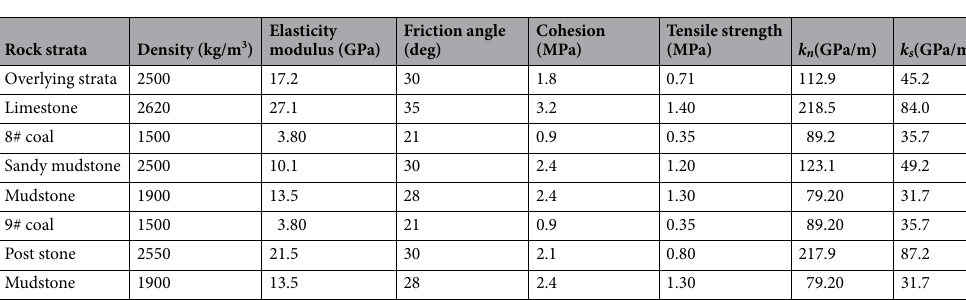
Table 1. Mechanical parameters of the rock strata for the numerical model.